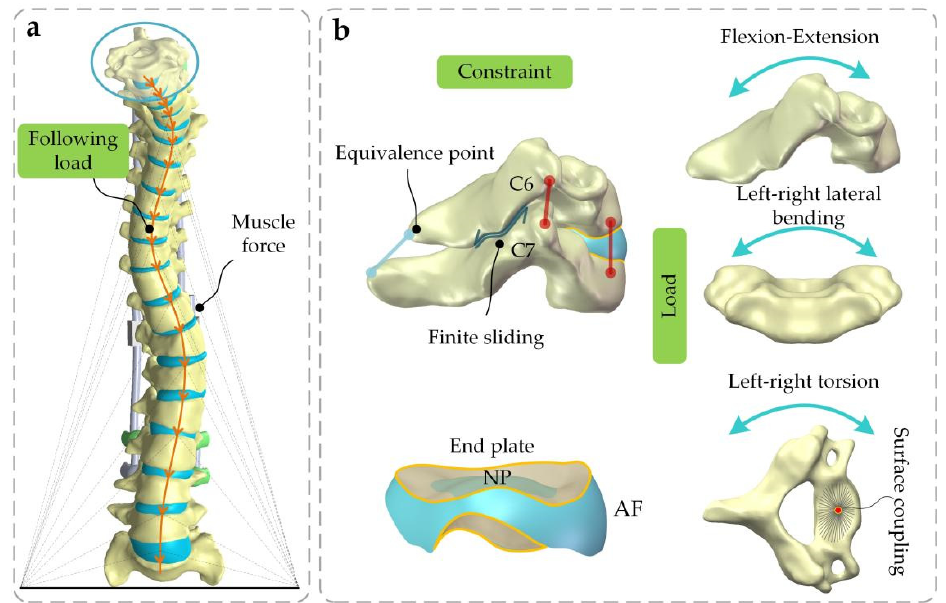
Figure 4. ( a ) Muscle force and pressure on the vertebra can be converted into the following loads when passing down from a direction perpendicular to the surface of each vertebra [23]. ( b ) Face-to- face binding was used between vertebra and IVD, and finite sliding was utilized between facet joints. Six directional torque loads were applied in the superior extremity of C6: Flex, Ext, LB, RB, LT, and RT, following the vertebral surface coupled to a point.